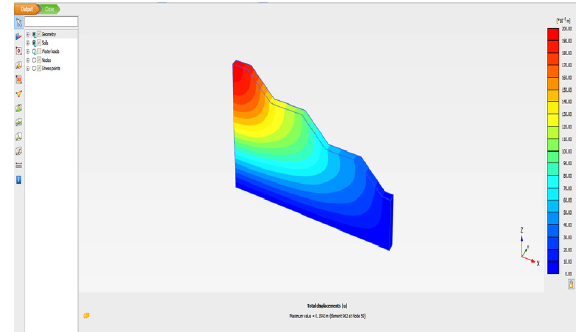
Figure 8. The vertical displacement of the embankment